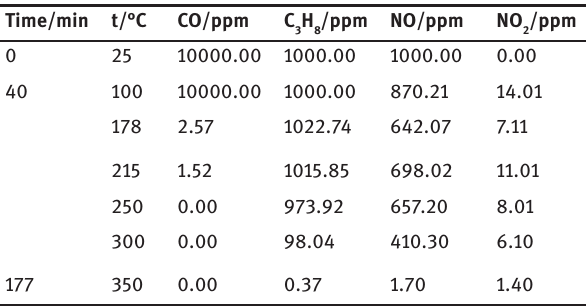
Table 1: Residual concentration of simulated exhaust gases over optimized catalyst.